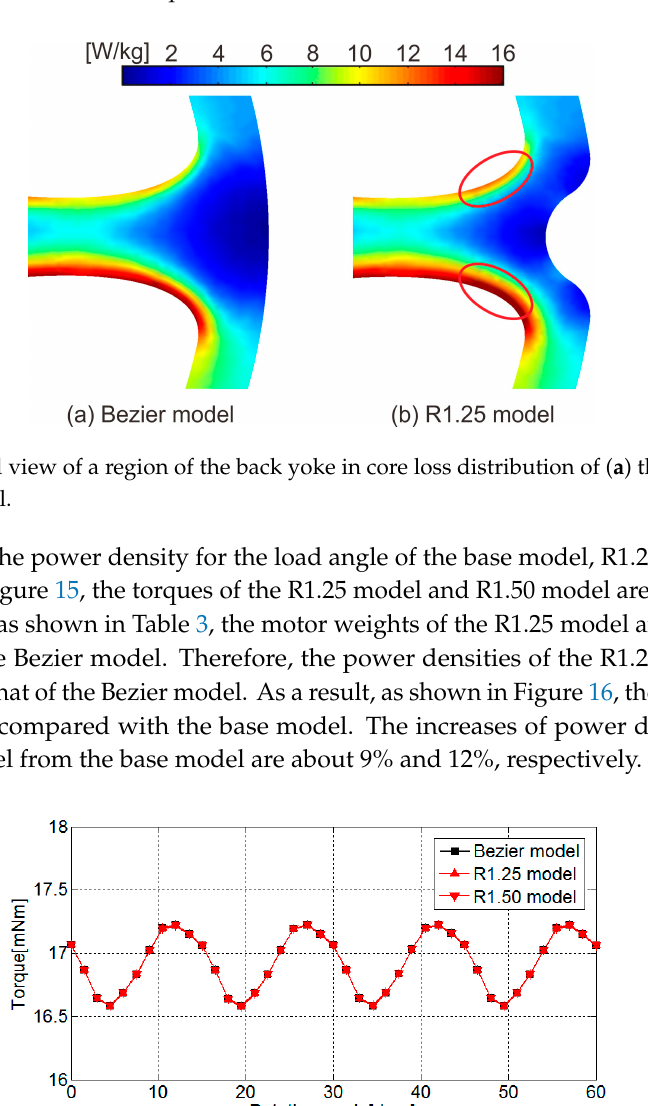
Figure 16. Power density for load angle of the base model, R1.25 model, and R1.50 model. 4. Conclusions In this paper, the stator core shape design for improving the power density of a small SPM motor is proposed. The design is carried out in two steps. The first design reduces the core loss, and the second design improves the power density. The Bezier curve used for the first design not only decreases the core loss of a motor, but it also has an effect that extends the low magnetic flux density region in the back yoke part. Therefore, in the second design, the power density of a motor is improved by cutting out the low magnetic flux density region, without decreasing the torque. As a result, it is shown that our technique is useful as a stator core shape design method for decreasing core loss and improving power density. However, neither the stator core shape defined by a Bezier curve nor the shape cut out in the back yoke have been optimized. The characteristics of the small motor may become better by an optimal design. Additionally, since these results are theoretical, it is necessary to actually manufacture a small SPM motor and verify the validity of these results. Author Contributions: Conceptualization, N.S.; Methodology, N.S.; Software, N.S.; Validation, N.S.; Formal analysis, N.S.; Investigation, N.S.; Resources, N.S. and M.E.; Data curation, N.S.; Writing, N.S.; Visualization, N.S.; Supervision, M.E.; Project administration, N.S.; Funding acquisition, N.S. All authors have read and agreed to the published version of the manuscript. Funding: This work was supported by Grant-in-Aid for Scientific Research (C) (No. 18K04101). Conflicts of Interest: The authors declare no conflict of interest. References